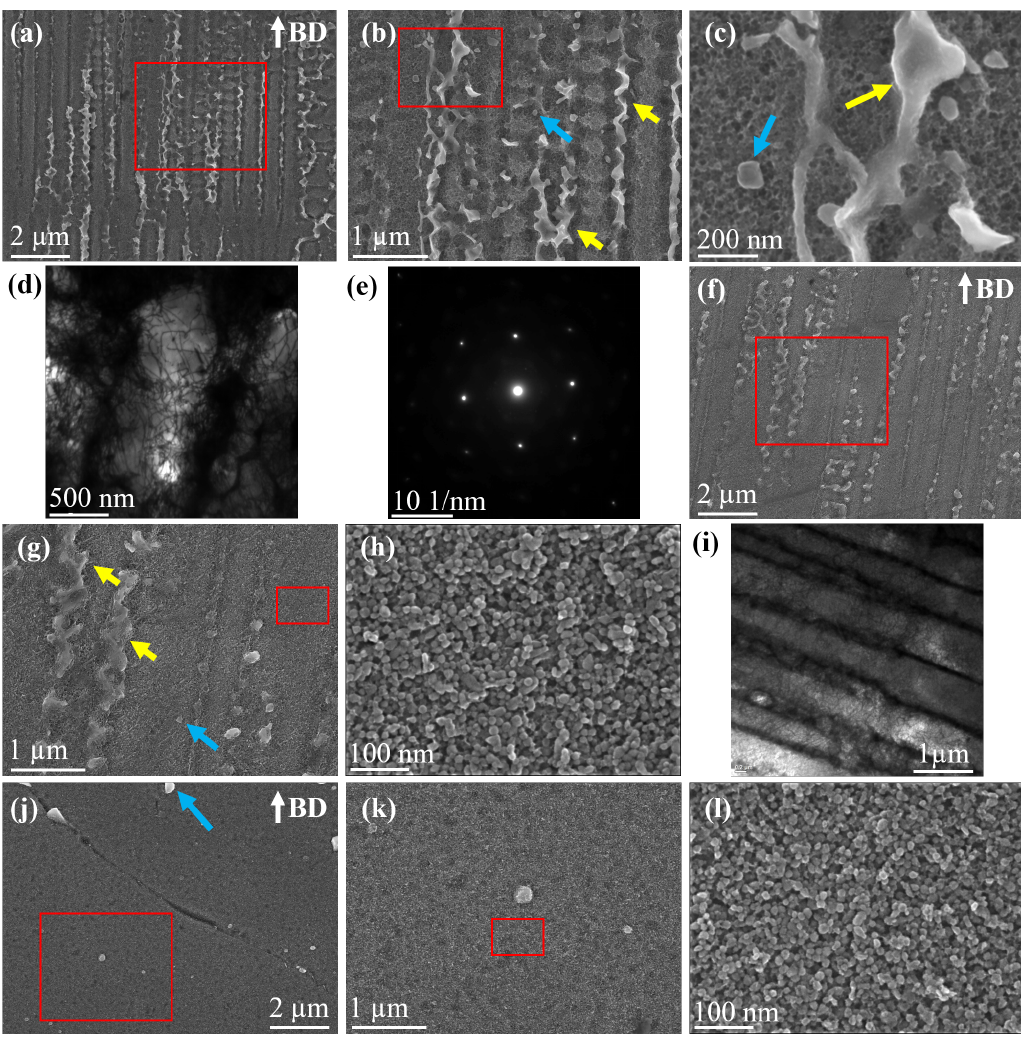
Figure 8. ( a – e ) AB condition. ( a – c ) SEM images at different magnifications showing the cellular morphology, Laves phase and NbC. ( d ) TEM image showing highly dense dislocation network at the cell boundaries. ( e ) SAED patter showing absence of superlattice reflections of the strengthening precipitates. ( f – i ) DA condition. ( f – h ) SEM images at different magnifications showing the cellular morphology, Laves phase, NbC and strengthening precipitates. ( i ) TEM image showing highly dense dislocation network at the cell boundaries. ( j – l ) SEM images at different magnifications showing NbC and strengthening precipitates in the HSA condition. Note: Yellow arrows point to Laves Phase, blue arrows point to